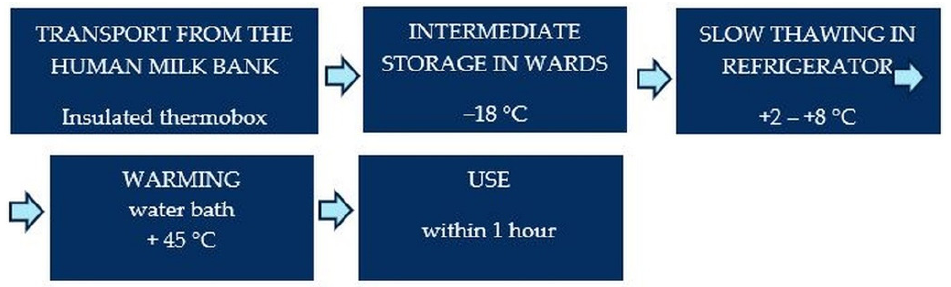
Figure 1. Schematic description PBM use after delivery.